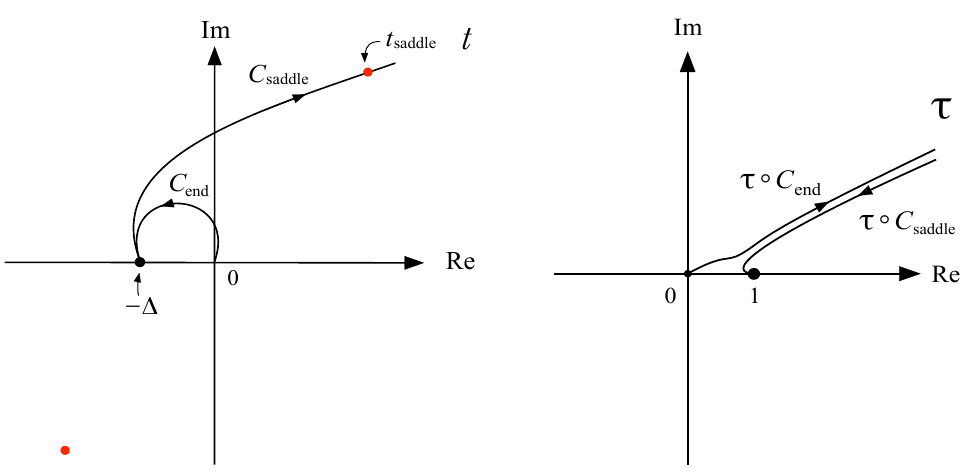
Figure 11 . Steepest descent contours C end and C saddle of the integrand of the amplitude F ( x; (cid:1)), shown left in the Schwinger plane t , and right in the Borel plane (cid:28)